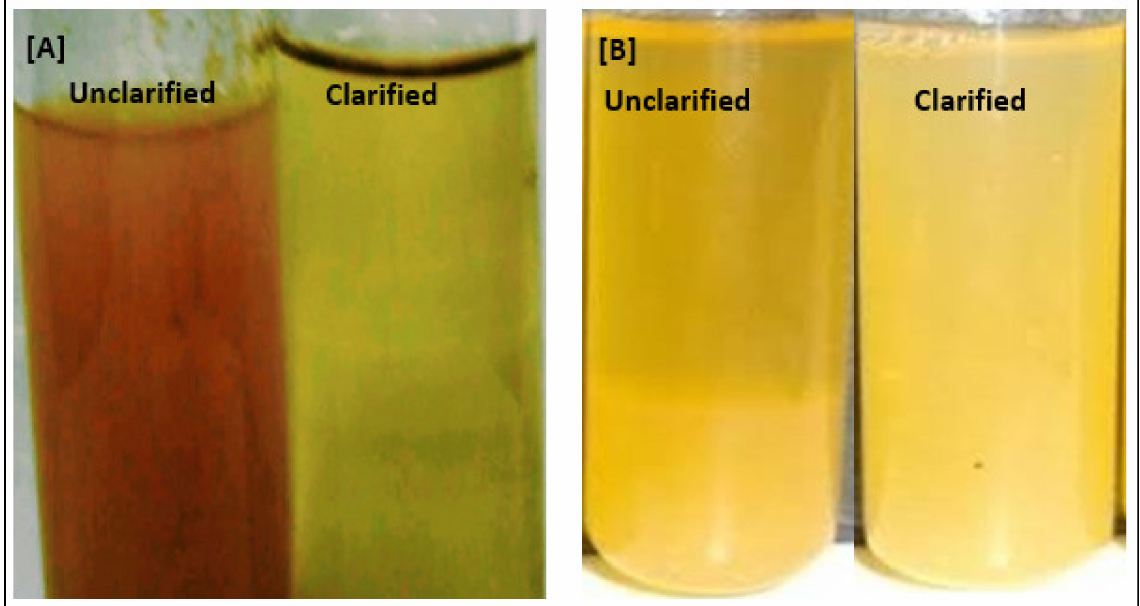
Figure 5. Juice clarification. ( A ): unclarified and clarified apple juice. ( B ): unclarified and clarified orange